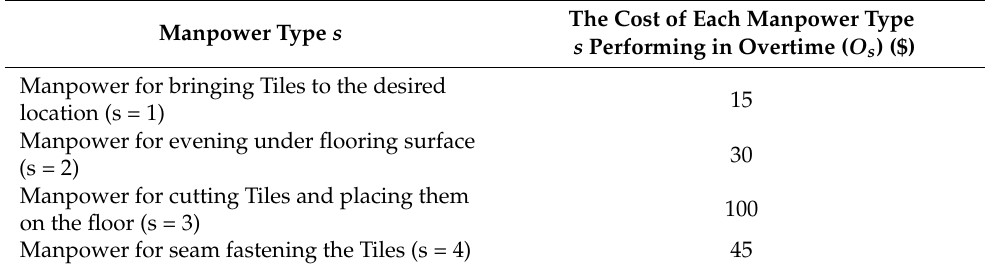
Table 14. Data for manpower overtime operation cost for sub-tasks of flooring task. Manpower Type